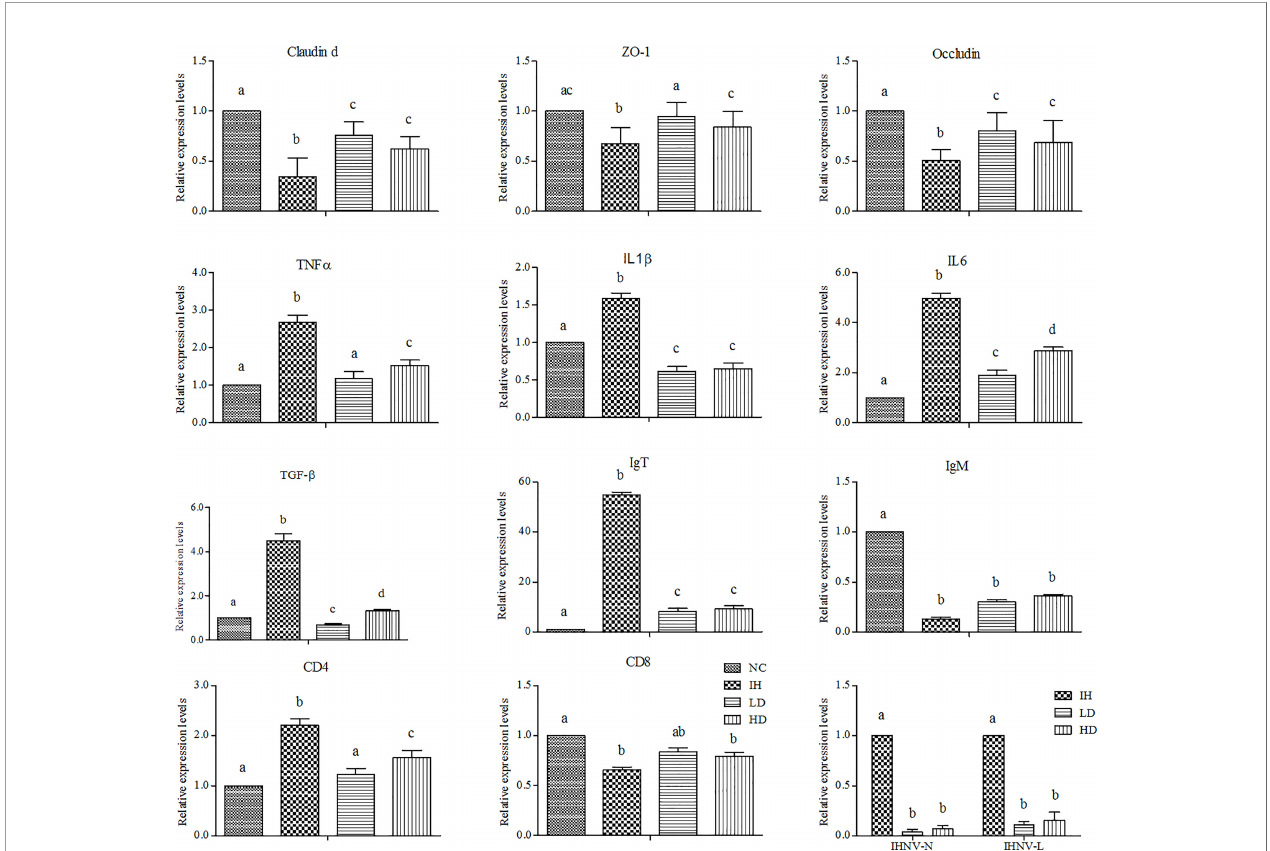
FIGURE 3 | Changes in the expression of intestinal immune-related genes after dietary 1% and 2% of crude lentinan (CLNT) in infectious hematopoietic necrosis virus (IHNV) – infected rainbow trout ( P <0.05). Different letters indicated signi fi cant differences among the